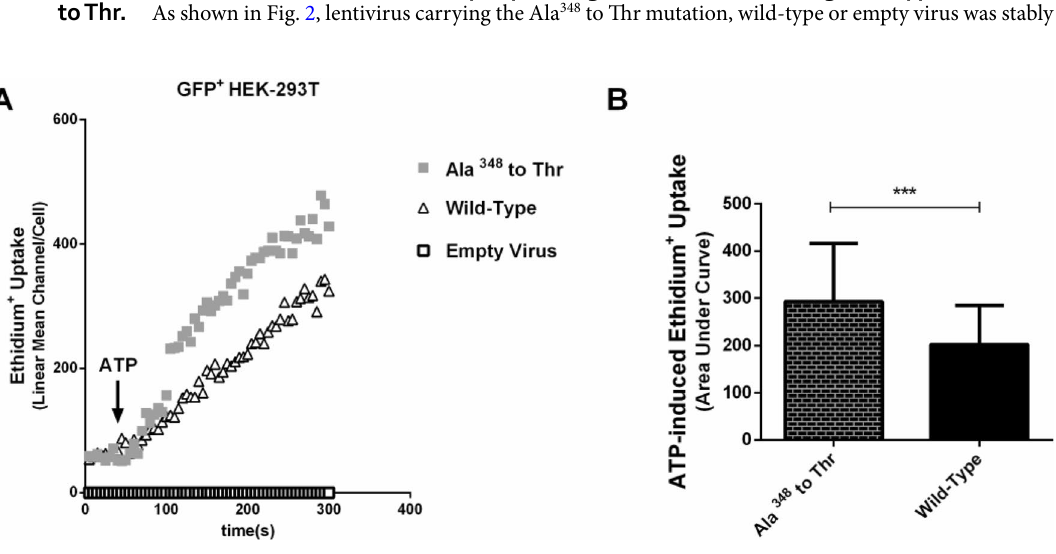
Figure 1. The functional effect of Ala 348 to Thr in transfected HEK-293T cells. ( A ) P2X7-dependent ethidium + uptake induced by 1 mM ATP (applied at arrow) in Ala 348 to Thr compared with Wild-Type. ( B ) Mean ATP- induced ethidium + bromide uptake was quantified by calculating the area under the dye uptake curve for cells expressing Ala 348 to Thr. *** P < 0.001.